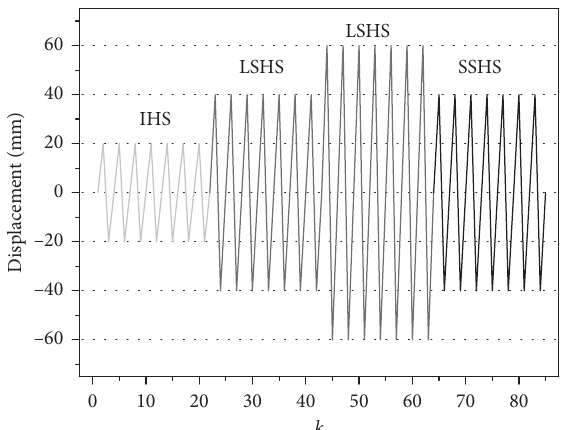
Figure 2: The SV displacement pattern, which was composed of four CC